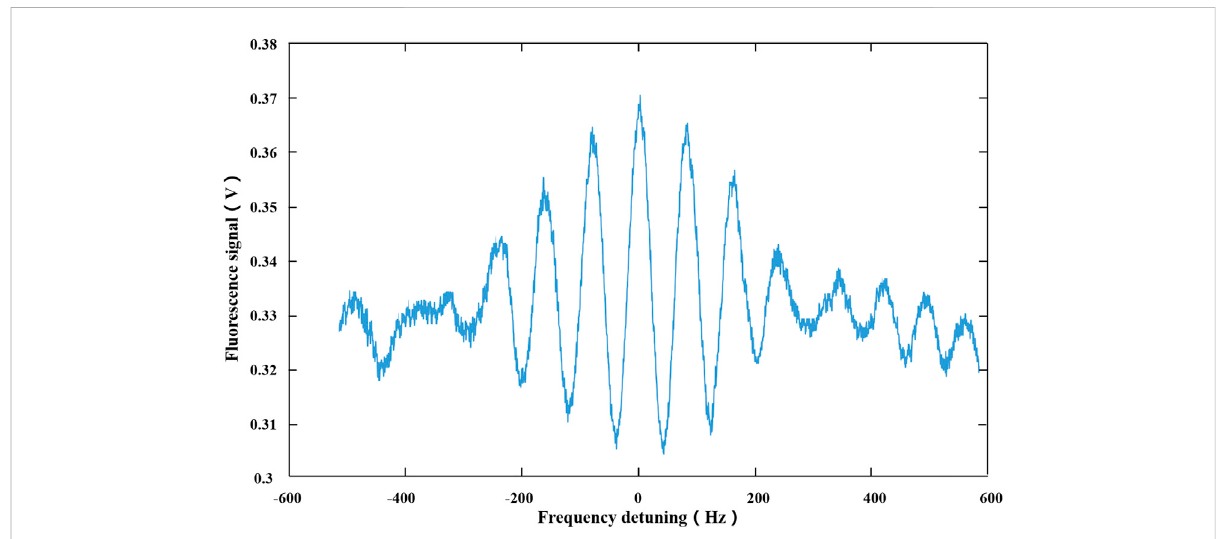
FIGURE 4 Ramseyfringeofacoldcesiumatomicbeam.Theabscissaisthemicrowavefrequencydetuning,relativetothefrequencyof3 → 4transitionof Cs D 2 line. The ordinate is the fl uorescence signal amplitude detected by the photodiode.